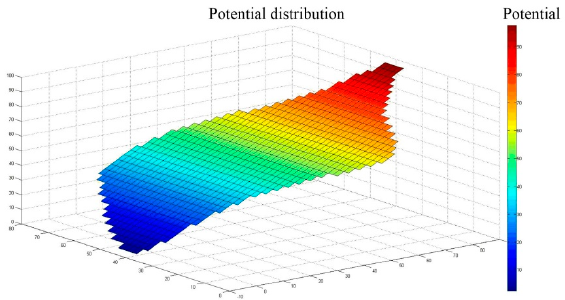
Figure 5. Potential distribution of the conductive plane.